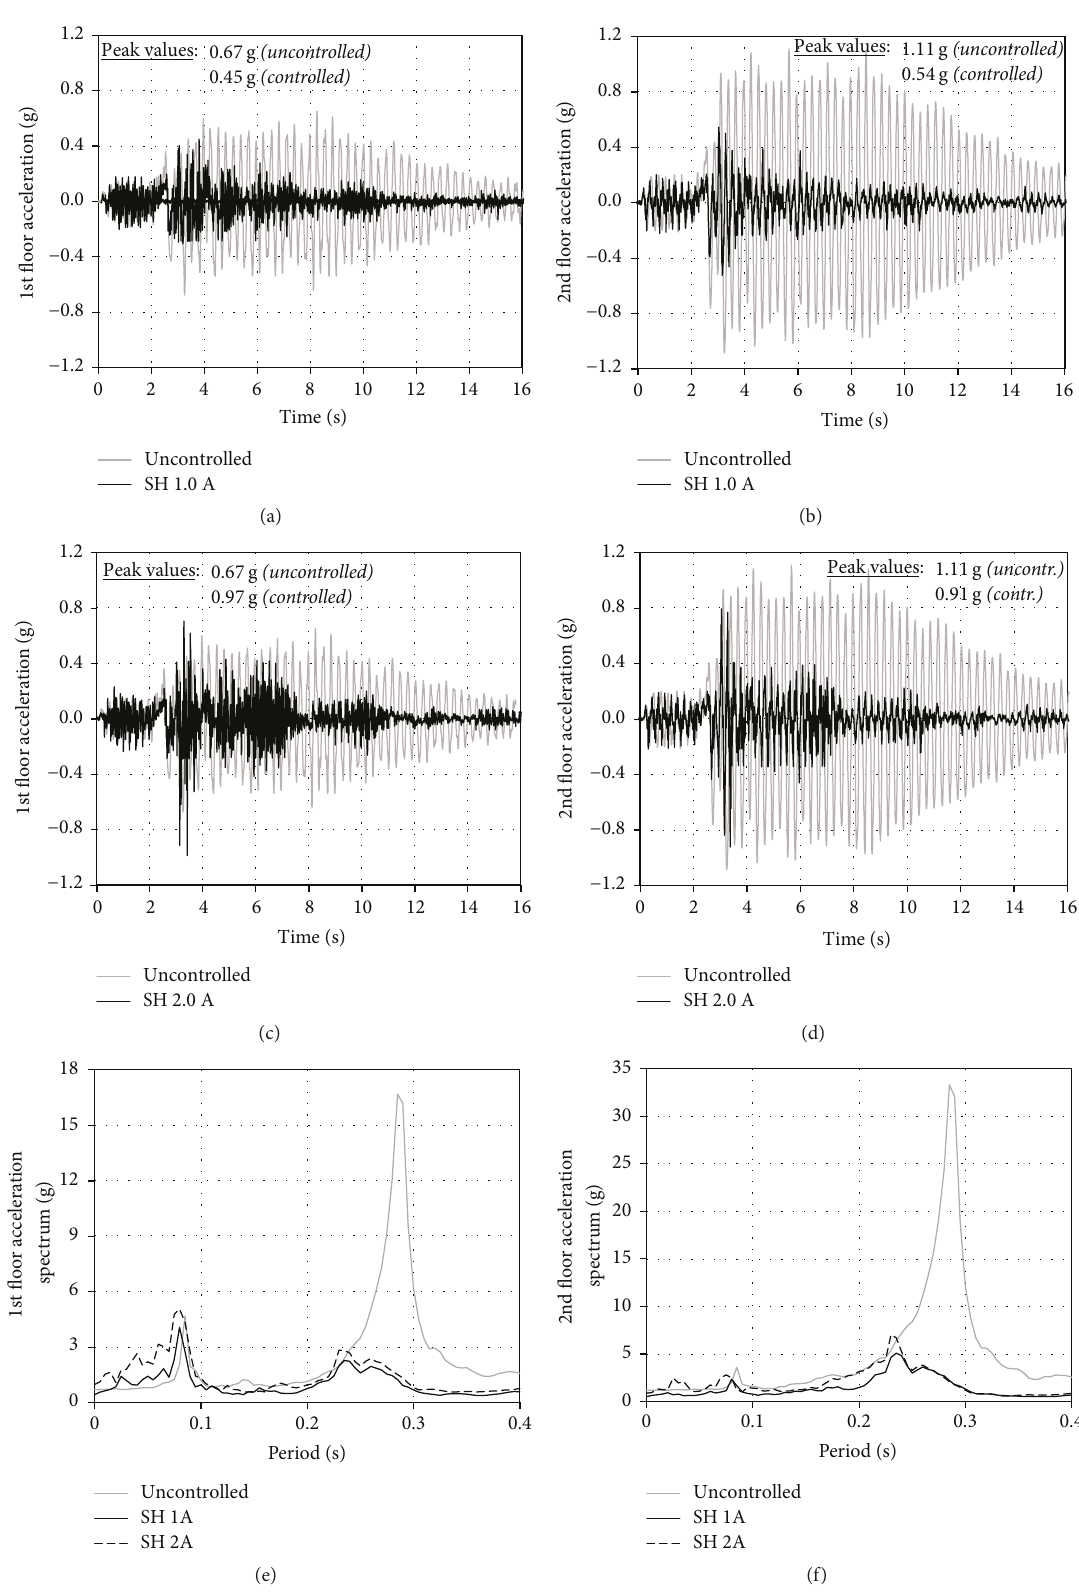
Figure 13: Comparison of uncontrolled and controlled (tests SH1A and SH2A) response in terms of floor acceleration time histories (a to d) and spectra (e,